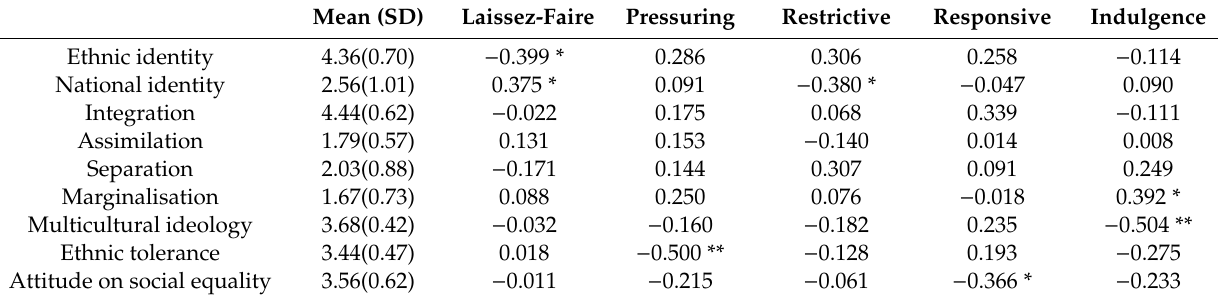
Table 3. The association of acculturation with five domains of CIYCFP ( n =